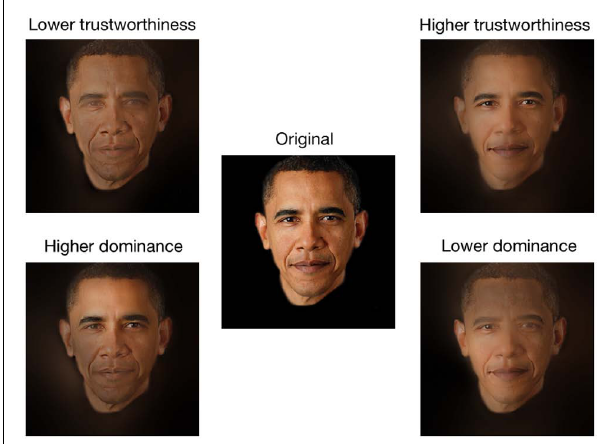
FIGURE 8 |As a final exploration of the generalizability of our manipulation, we set out to find one of the most emblematic figures on earth. Google spoke: Barack Obama.The intact image (center) was passed through an untrustworthy (top left), trustworthy (top right) dominant (bottom left), and a submissive filter (bottom right). Original image source: http://change.gov/newsroom/entry/new_official_portrait_released/.